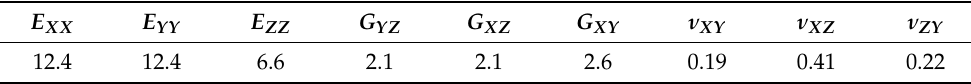
Table 6. Textile ply effective properties from FEM homogenization. Elastic moduli are in